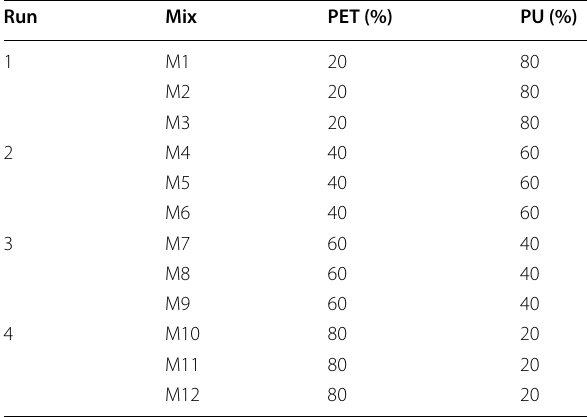
Table 1 Mix designs obtained from RSM